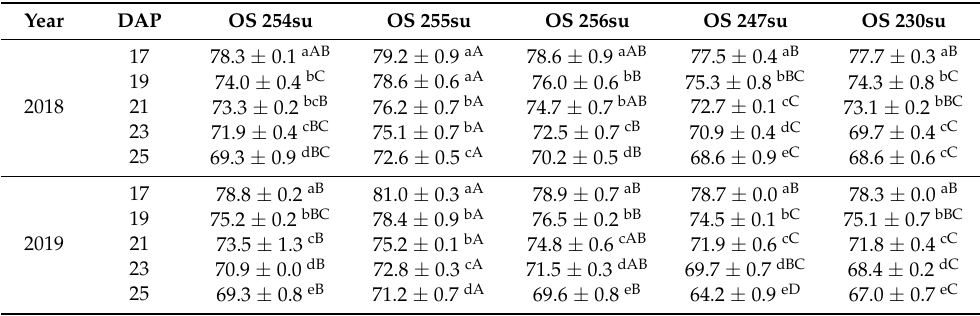
Table 2. Kernel moisture at harvest (%) in five sugary ( su1 ) sweet corn hybrids at five harvest dates 17–25 days after pollination (DAP) in two growing seasons (Osijek, 2018 and 2019). The different lowercases show significant differences among the harvest dates within hybrids ( p < 0.05). The different capital letters show significant differences among the hybrids ( p < 0.05).